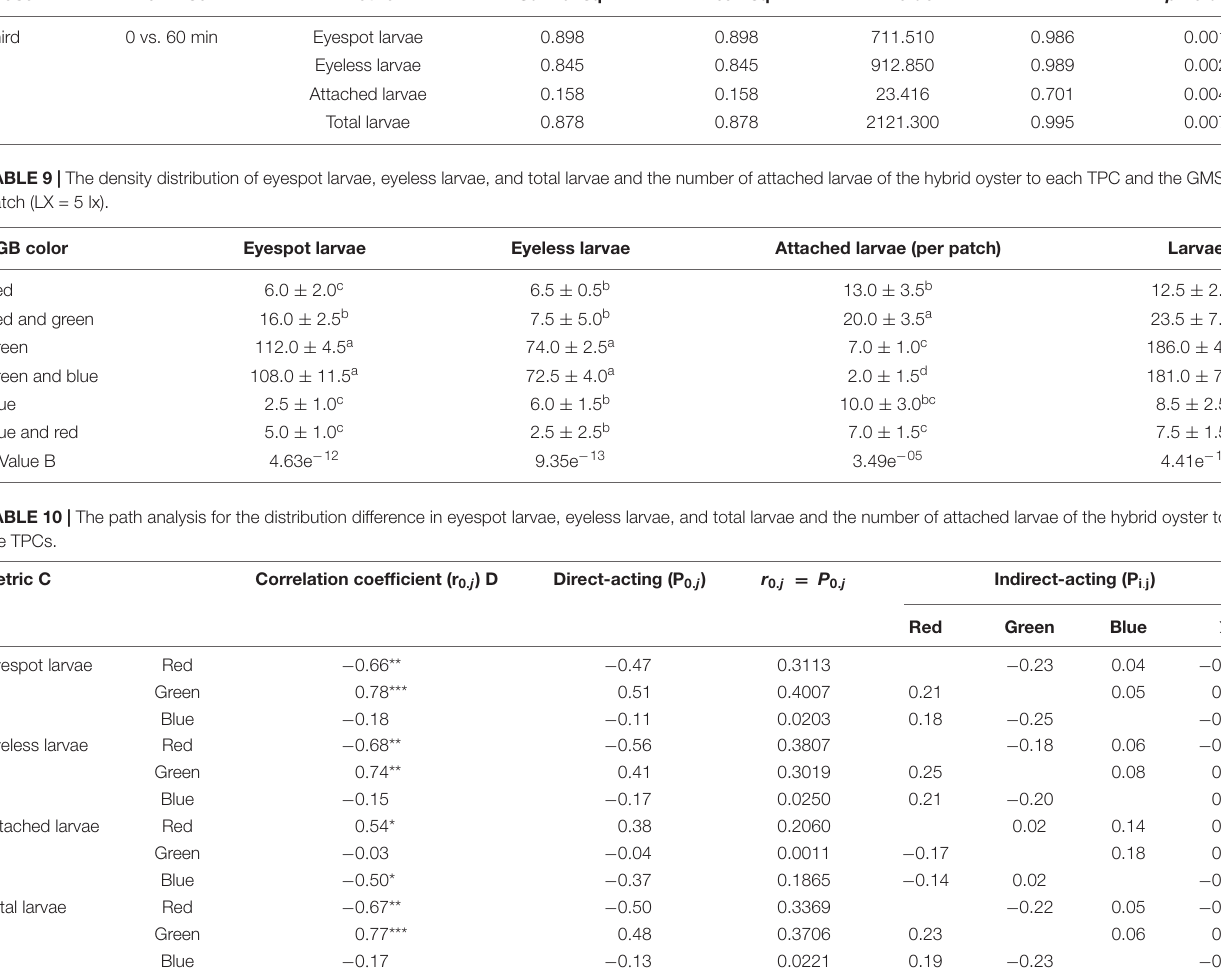
TABLE 8 | PERMANOVA analysis for the distribution difference in eyespot larvae, eyeless larvae, and total larvae and the number of attached larvae of hybrid oysters with time. Phase Pairwise